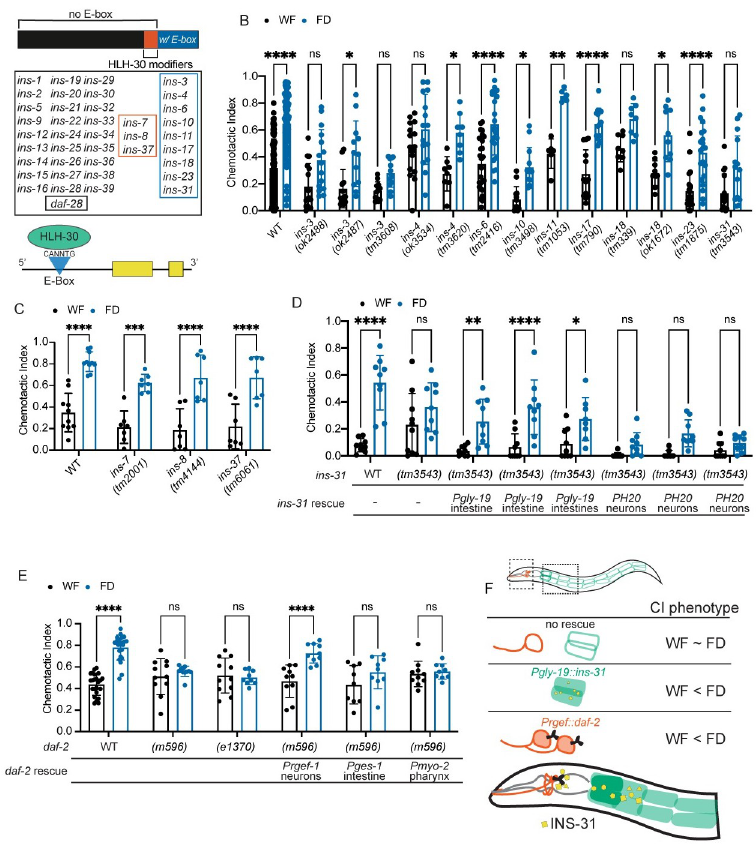
Fig 5. Sensory integration changes require HLH-30-regulated insulin while daf-2 is required in neurons. (A) HLH-30 interacts with C . elegans insulin peptides. Of the 40 insulin-like peptides encoded in the C . elegans genome, 22% have an HLH-30 binding motif (CANNTG E-box, blue) in the 5’ UTR ( < 300bp upstream of start site) [52]. 7% of insulins have been shown to regulate the localization of HLH-30 but do not contain an E-box (orange, “HLH-30 modifiers”). An illustration of a representative insulin peptide with two yellow exons and an upstream E-box with HLH-30 initiating transcription. (B) All insulins known to contain an HLH-30 binding motif in the 5’ UTR were tested using the standard sensory integration assay. When available, more than one allele was tested (N � 8) for each insulin, with wildtype (N2) animals tested with each mutant. (C) Insulins previously shown to regulate HLH-30 localization ( ins-7 , ins-8 , ins-37 ) were tested using the standard sensory integration assay alongside wildtype (N2) control. N � 7. (D) ins-31 mutants and tissue-specific rescues are tested in the standard sensory integration assay. N � 8 for each strain tested alongside wildtype N2. ins-31 is rescued in neurons and intestines using tissue-specific promoters. (E) daf-2 mutants and tissue-specific rescues are tested in the standard sensory integration assay N � 9 for each strain tested alongside wildtype N2. daf-2 is rescued in neurons, intestines, and pharynx using tissue-specific promoters. (F) Schematic showing requirement of ins-31 in the intestine and daf-2 in neurons. CI phenotype means Chemotactic Index phenotype, where wildtype animals display a chemotactic index of WF < FD. All graphs were analyzed using a two-way ANOVA, determined to have significant differences across well-fed and food-deprived conditions. WF/FD comparisons were then performed as pairwise comparisons within each genotype or treatment as t-tests with Bonferroni’s multiple comparisons test. � p < 0.5, �� p < 0.01, ��� p < 0.001, ���� p < 0.0001, ns p >